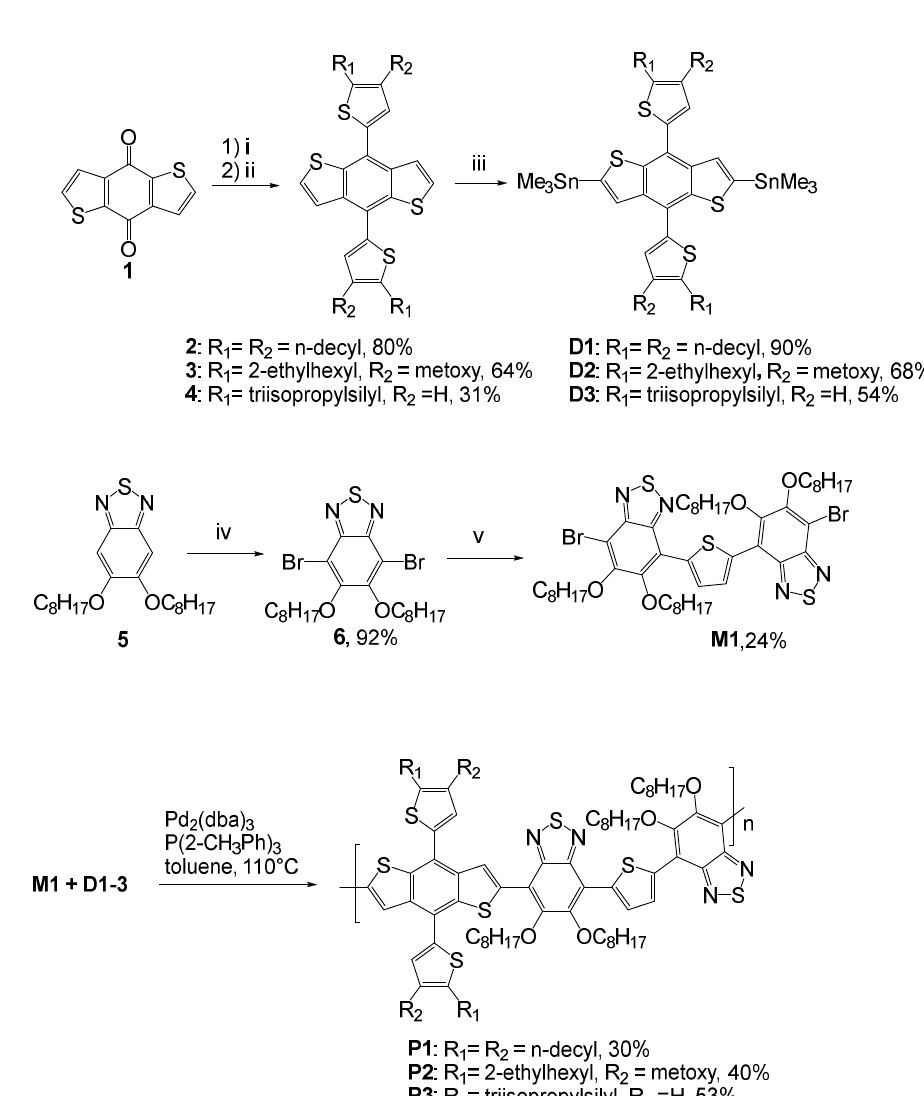
Figure 2. Synthesis of monomers D1 – D3 , M1 and conjugated polymers P1 – P3 . Conditions: i—(4,5- Figure 2. didecylthien-2-yl)lithium or (4-(2-ethylhexyl)-5-(methoxy)thien-2-yl)lithium or (5-(triisopropylsi-